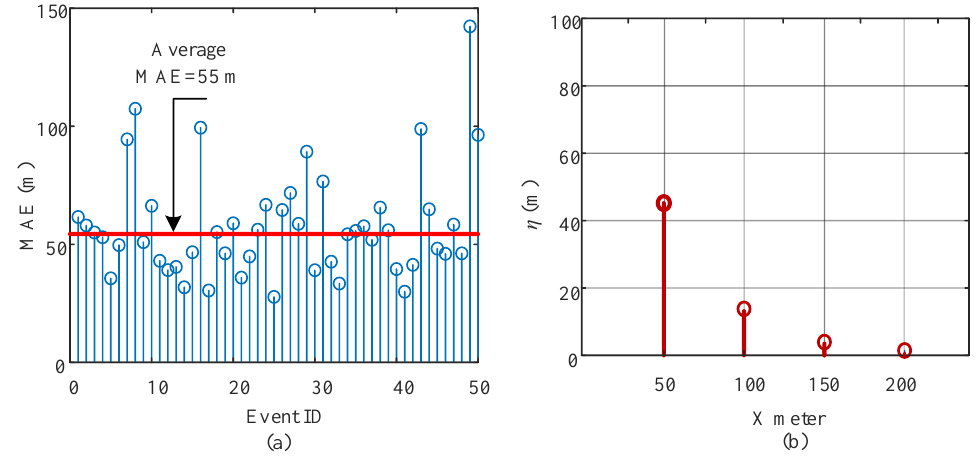
Figure 3. ( a ) MAE versus the event position ID, and ( b ) η value versus X